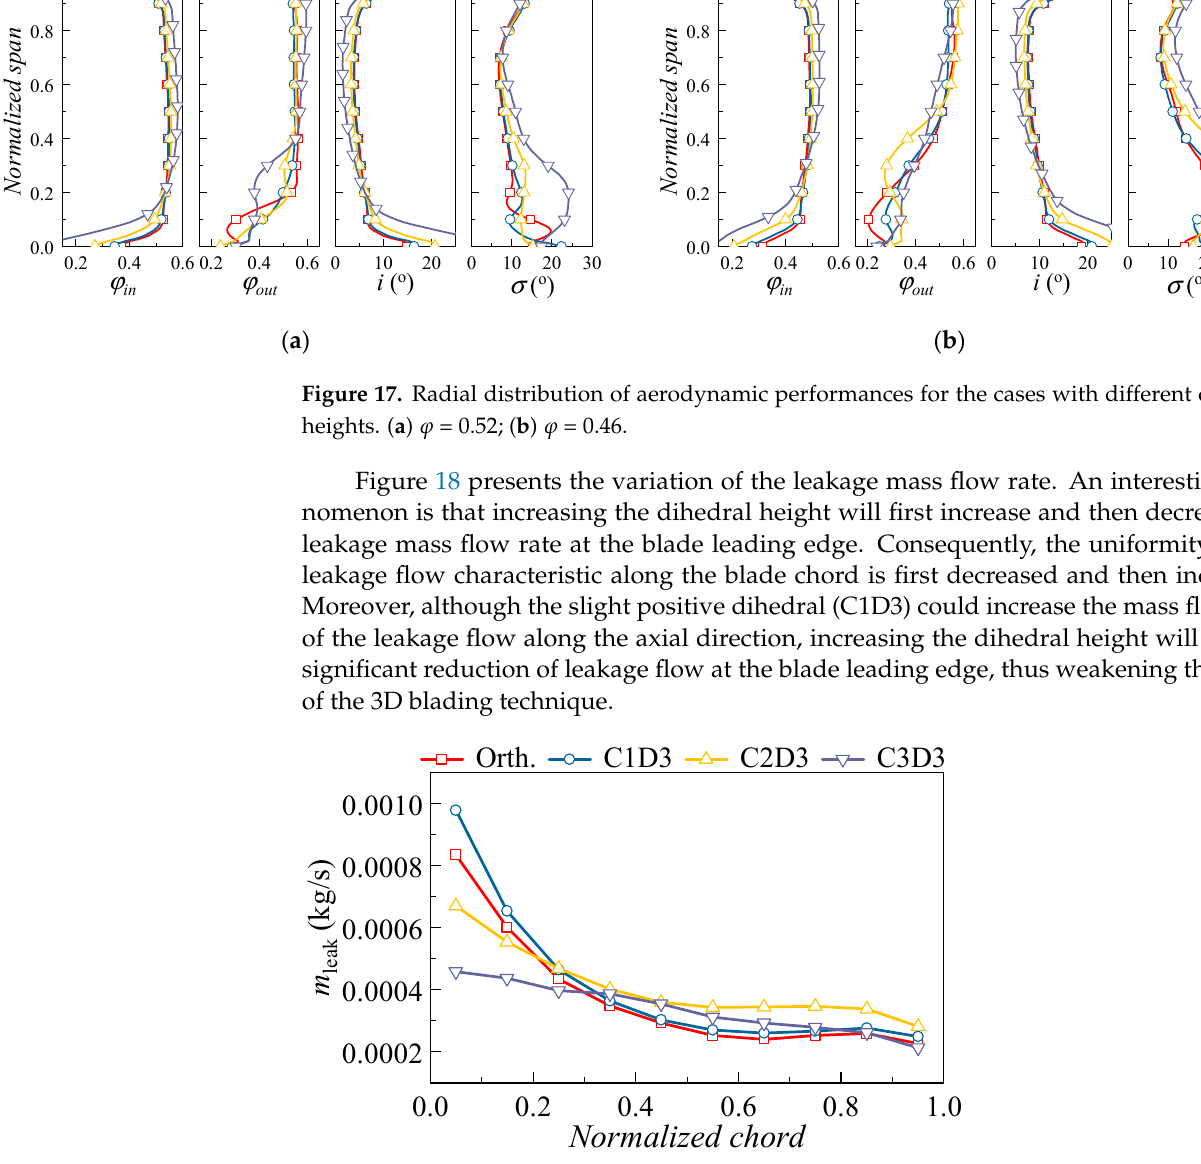
Figure 16. Flow field distribution for the cases with different dihedral heights.